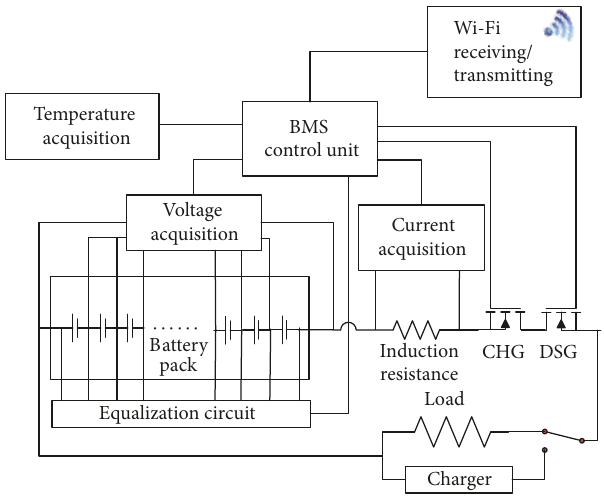
Figure 1: Architecture of the BMS (lower machine).